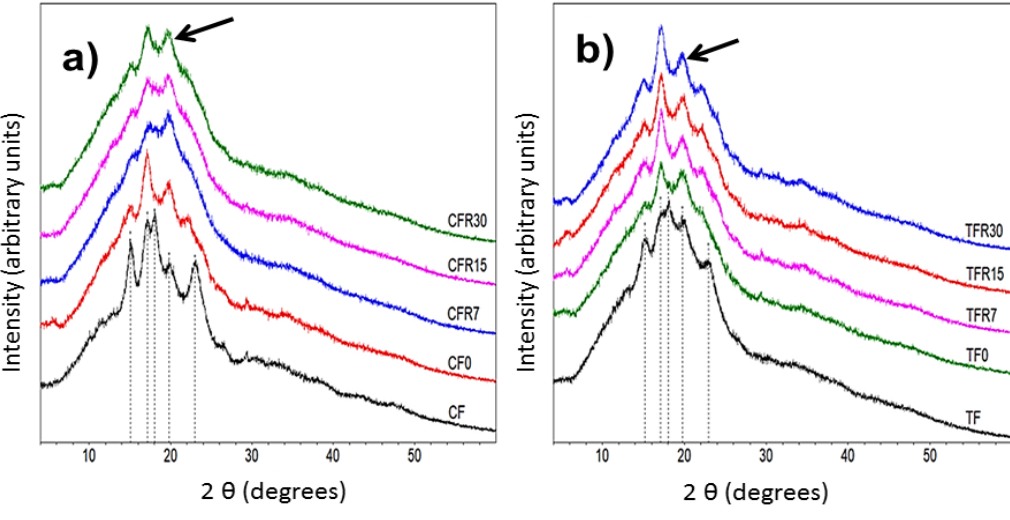
Figure 4. X-ray diffraction pattern of corn flours and corn tortilla flours obtained by the ( a ) industrial (commercial) and ( b ) traditional methods without refrigeration (TF, CF, TR0, CF0) and stored in refrigeration (4 °C) at different periods of time (7, 15, and 30 days).